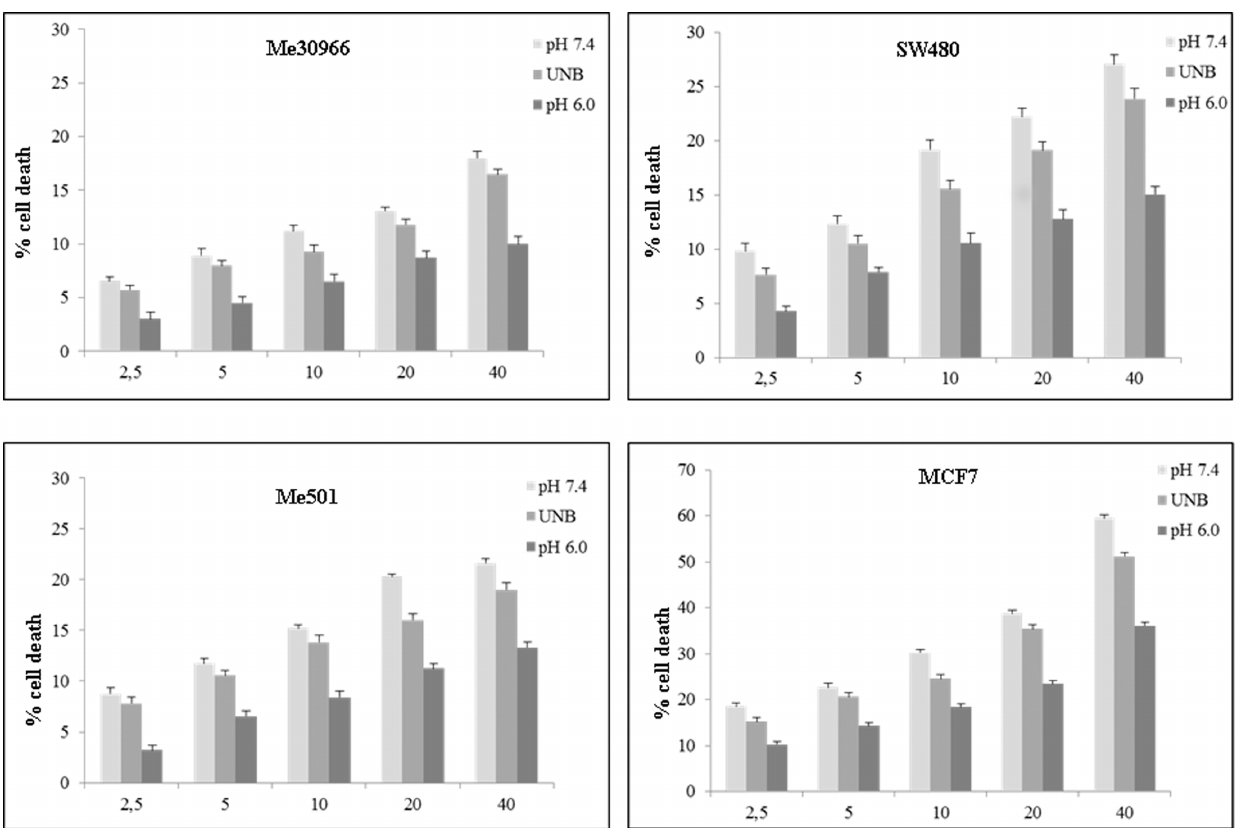
Figure 1. Cytotoxicity assay by Trypan blue exclusion method. Me30966, Me501, SW480 and MCF7 cell lines were incubated at pH 7.4, UNB and pH 6.0 conditions and treated with 2,5, 5, 10, 20 and 40 m M of CisPt. Representative of three independent experiments are reported.